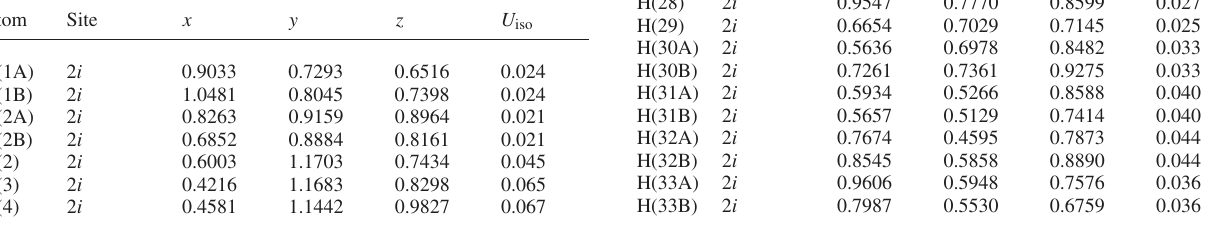
Table 2. Atomic coordinates and displacement parameters (in Å 2 ) .